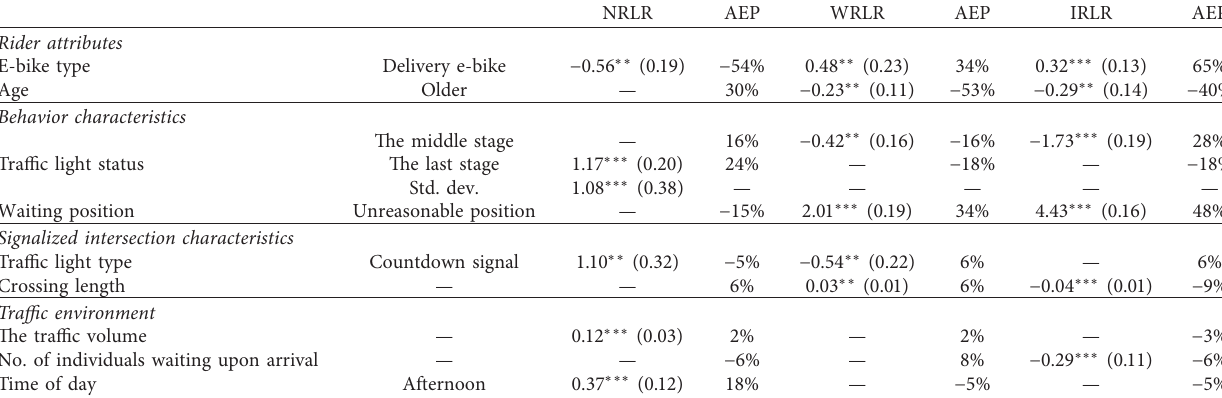
Table 4: Random parameter logit model estimation results (no interaction).